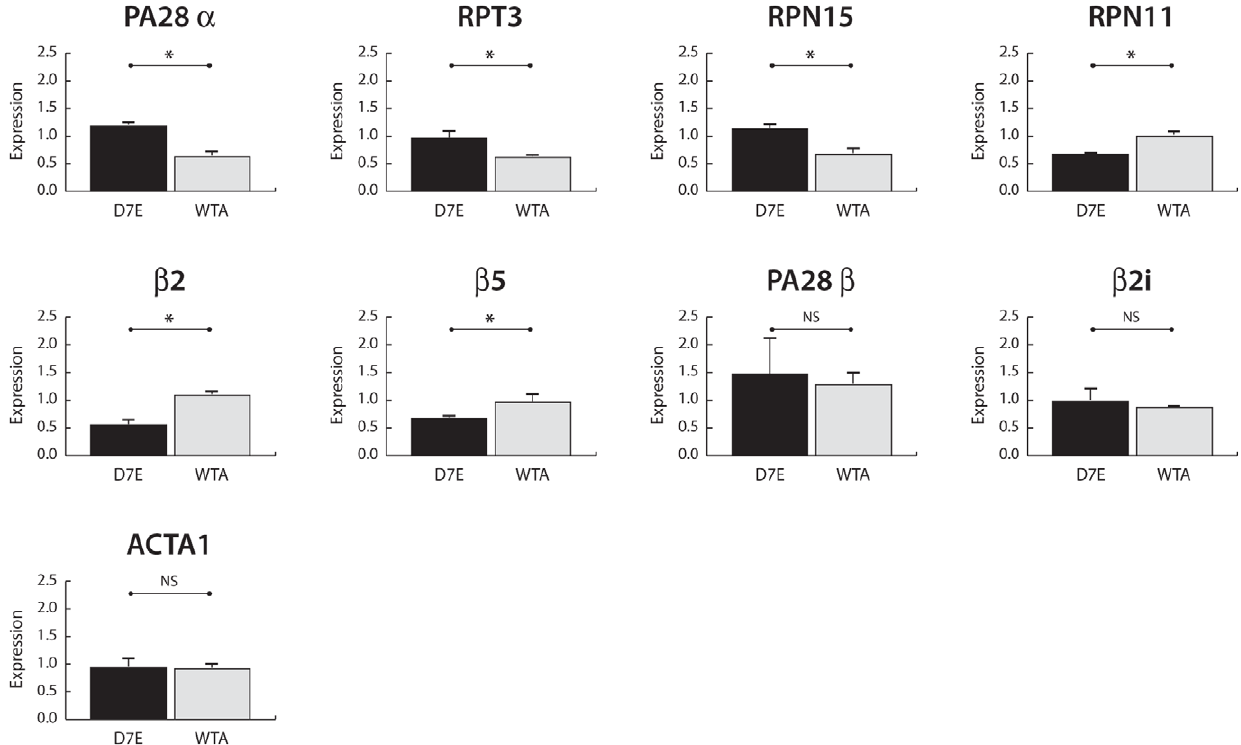
Figure 8. Validation of differential expression of disease associated genes in an unseen disease model. Results from qPCR experiments measuring differences in gene expression between control cells (WTA, N=3 independent cultures) and cells expressing the OPMD-associated PABPN1 with expanded repeat (D7E, N=3 independent cultures). Expression levels were normalized to Desmin to correct for differences in the myogenicity in the different cell cultures. Significant differences ( P , 0.05, Student’s T-test) between measured expression values in D7E and WTA cells are indicated by *, whilst NS stands for no significant difference. PA28 a , RPT3 , RPN15 , RPN11 , b 2 , and b 5 expression in IM2 cell lines were selected from the group of genes present in the interspecies disease domain. PA28 b (deregulated in human dataset) was selected as its role in assembling the lid subunit of the immunoproteasome is highly similar to PA28 a but not part of the interspecies disease domain. b 2i is one of the two genes that remained connected to the class node in the interspecies disease domain constructed by naı¨ve Dandelion approach. ACTA1 is a control for myotube formation.